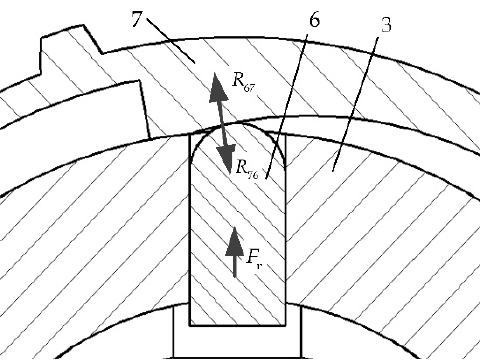
Figure 5. The force diagram of the contact between the single locking tab and the locking ring in the holding process. 3—Actuator working cavity, 6—Locking tab, 7—Locking ring.